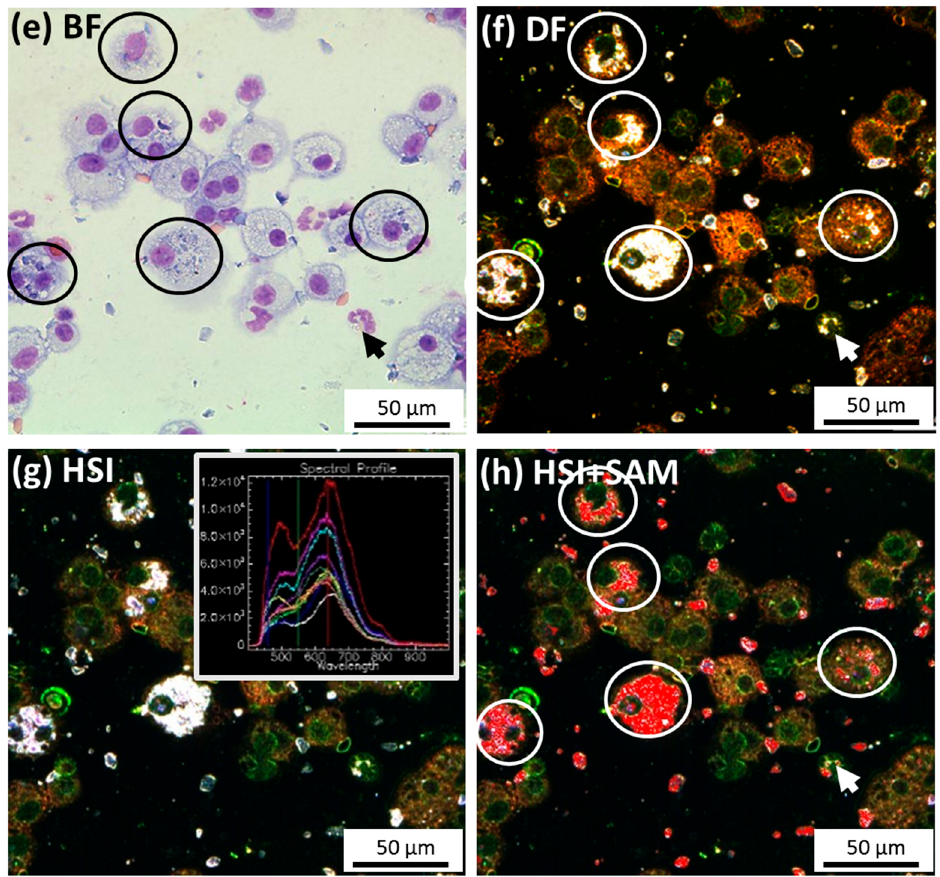
Figure 8. Identification of ZrO 2 -Acryl NPs and ZrO 2 -TODS in Pappenheim-stained cytospin preparations from rat BALF. Rats were administered 2.4 mg ZrO 2 -Acryl ( a – d ) or ZrO 2 -TODS NPs per lung ( e – h ) and lavaged three days post-administration. ( a , e ) Bright field images showing alveolar macrophages (encircled) and granulocytes. ( b , f ) Corresponding dark field images; light scattering material is contained in alveolar macrophages. ( c , g ) Corresponding pseudo-color HSI images; the spectral libraries for ZrO 2 -Acryl and ZrO 2 -TODS (insets) were collected from encircled macrophages laden with light-scattering material. ( d , h ) Matching of the spectral libraries from ( c , g ) with all data points according to the spectral angle mapping (SAM) method. ZrO 2 -Acryl- and ZrO 2 -TODS-positive pixels (superimposed in red) occur in macrophages and to a lesser extent in some granulocytes (arrows in a , b , d and e , f , h ).